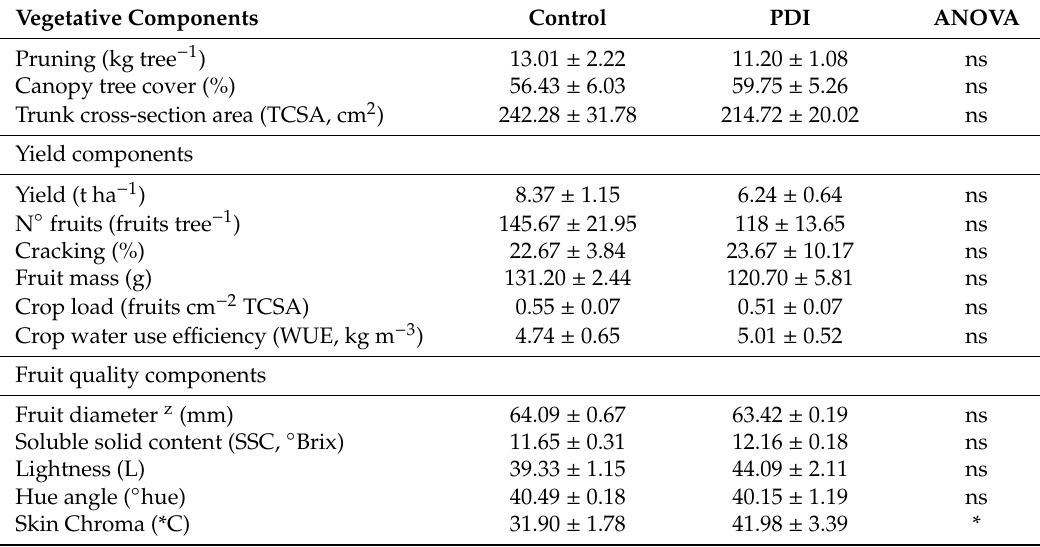
Table 1. Vegetative, yield, and fruit quality components in control and precise deficit irrigation (PDI)